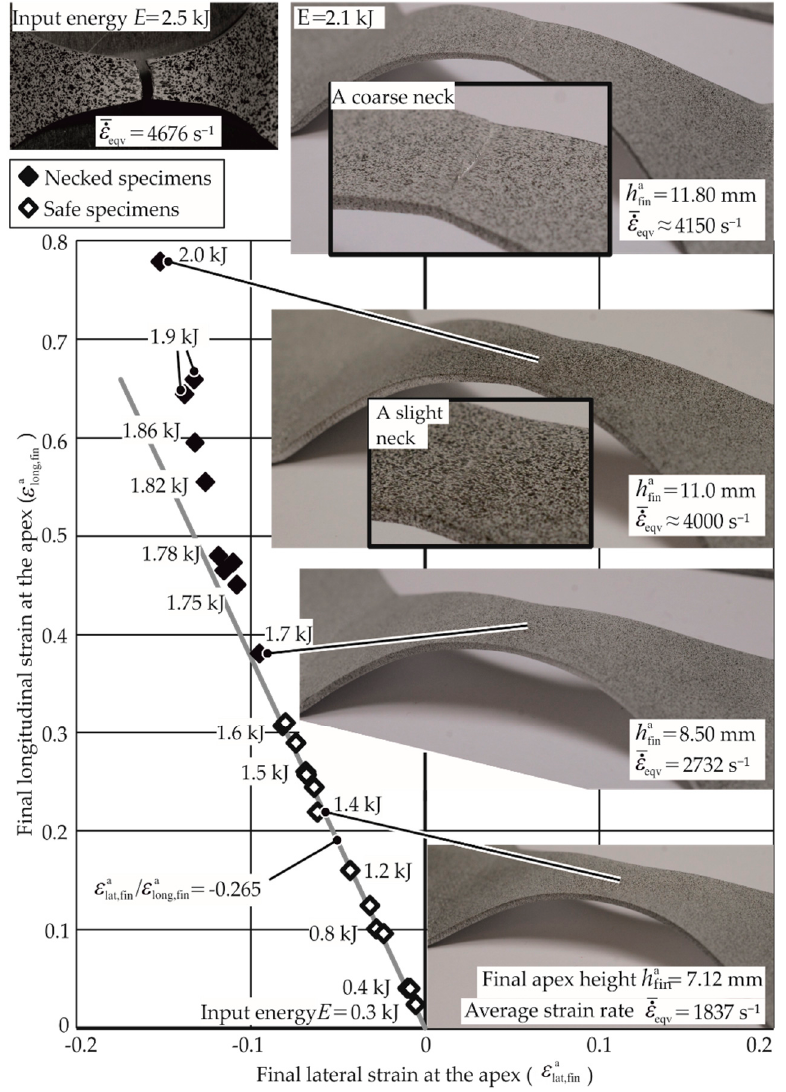
Figure 13. Electromagnetic forming limit test with the uniaxial specimen. Material: AA1050A-H24, 1 mm thick. Each diamond, empty or full, represents a separate experiment. The 𝜀 (cid:3032)(cid:3044)(cid:3049) (cid:3364)(cid:3364)(cid:3364)(cid:3364)(cid:3364)(cid:4662) is the average strain rate.